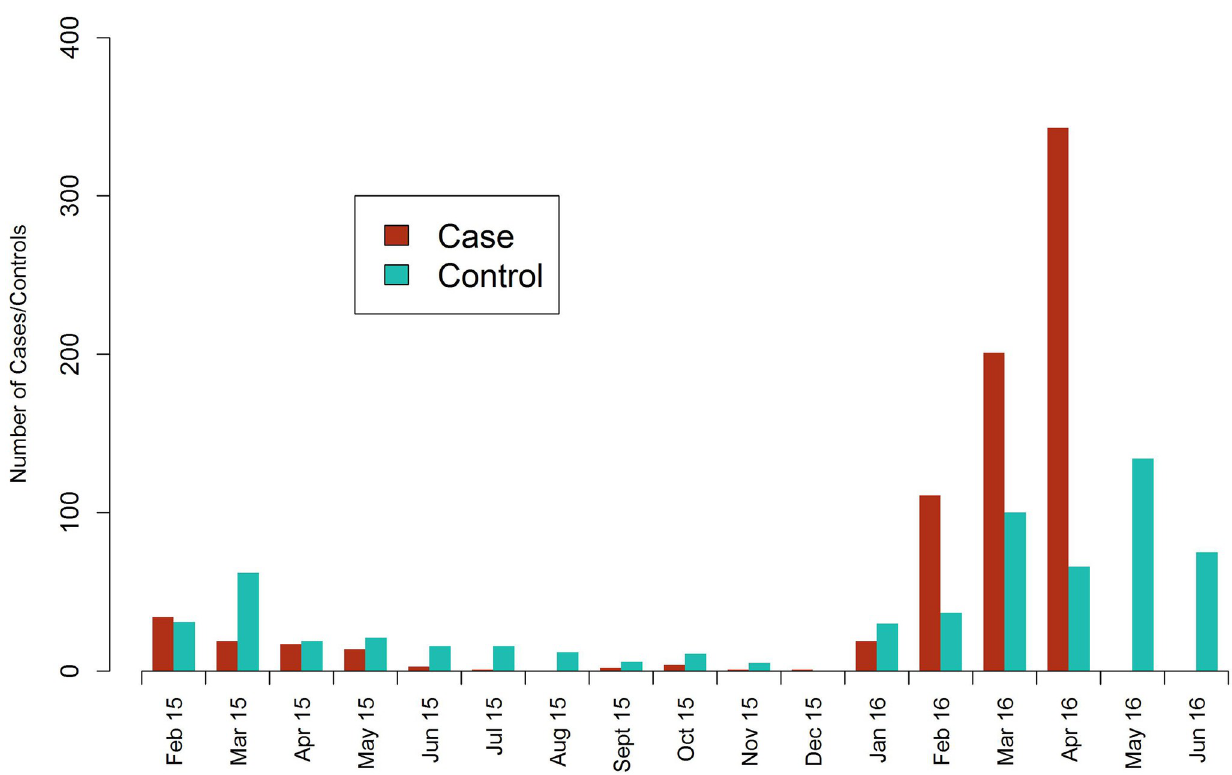
Fig 2. Monthly recruitment of 770 cases and 641 controls at six participating health facilities in Zambezi Region, Namibia between February 2015 and June 2016.